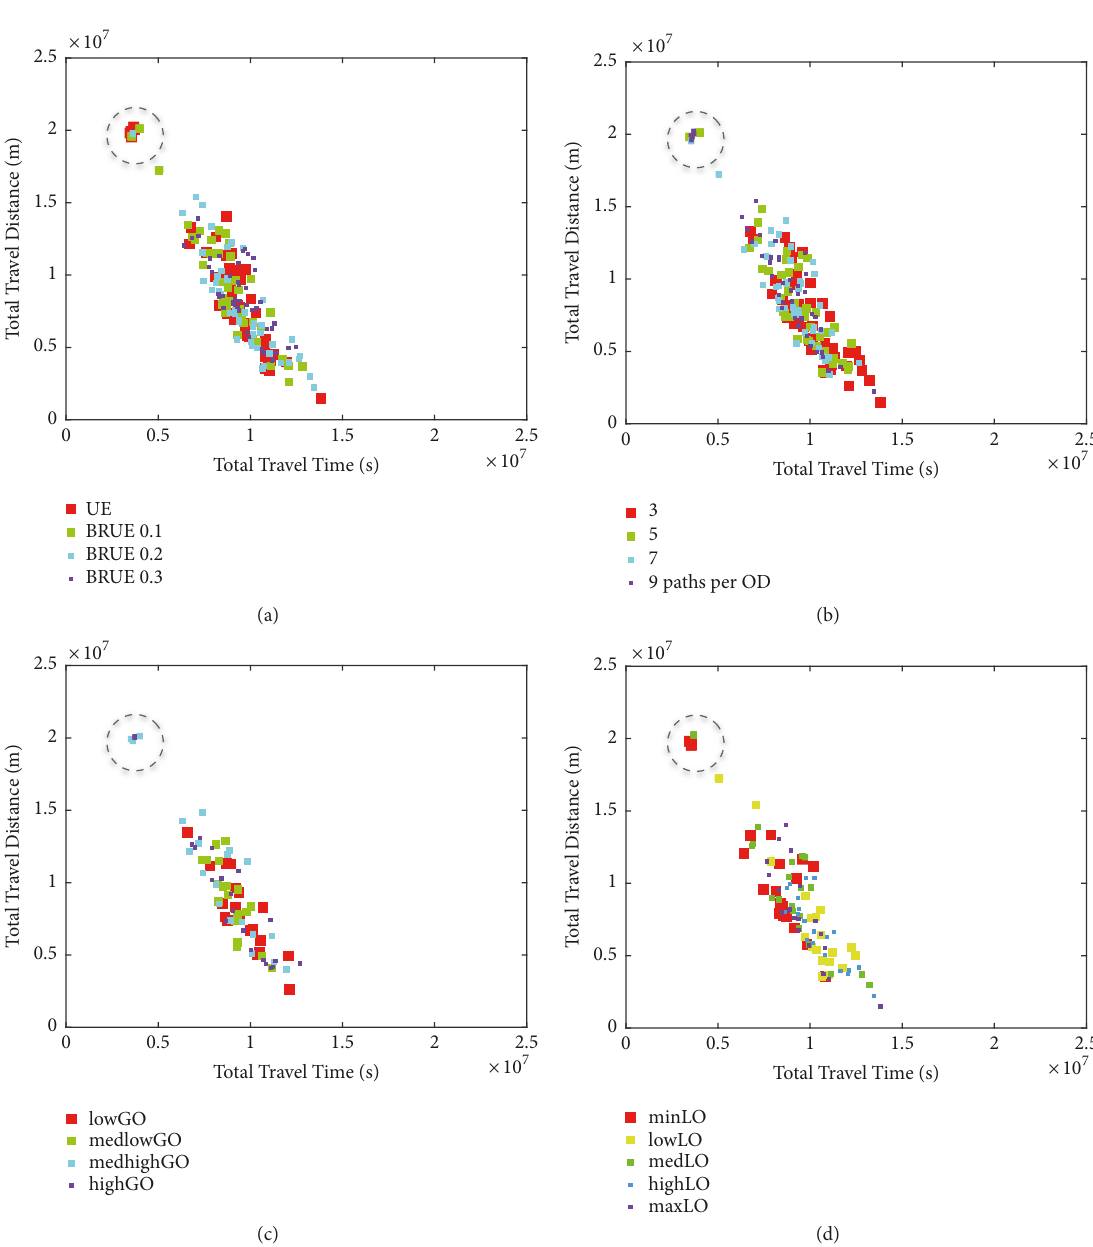
Figure 13: Final network states with demand level 5 and dynamic assignment, colored by (a) equilibrium criterion, (b) number of paths per OD, (c) global overlapping level, or (d) local overlapping